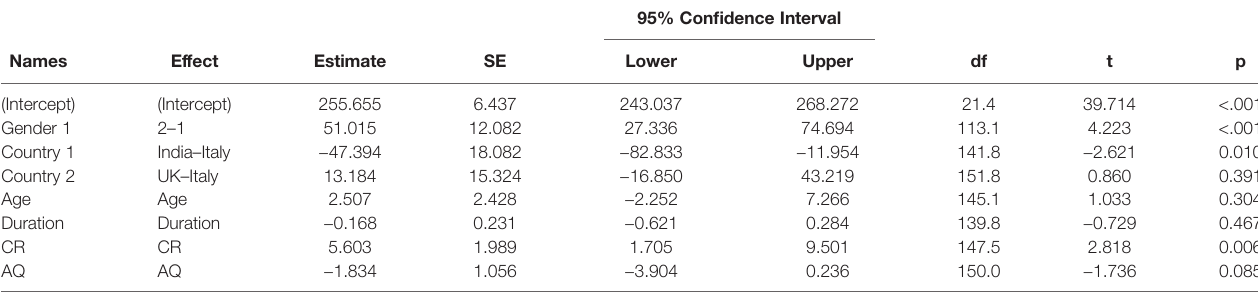
TABLE 2 | Results of the Hierarchical Linear Model-based Analysis.